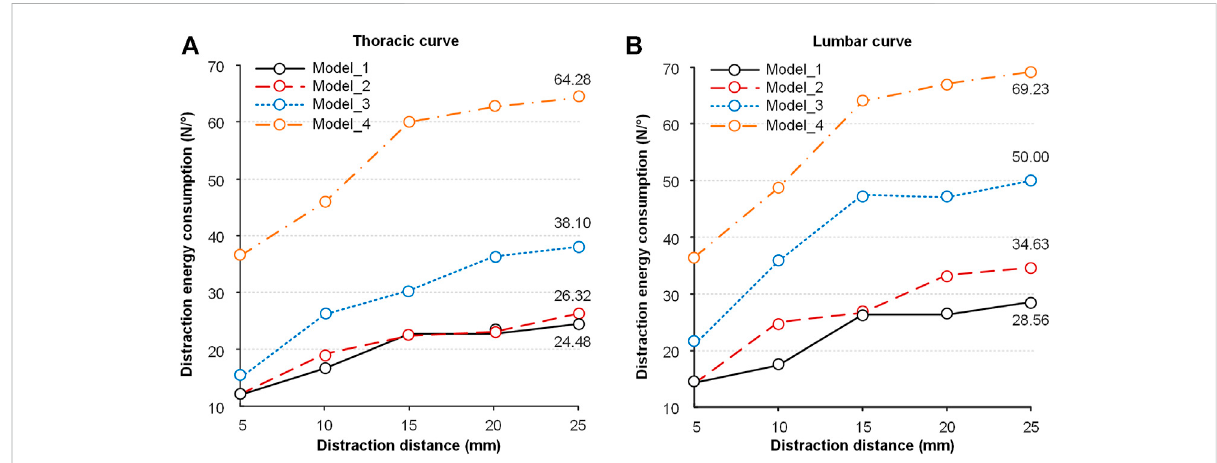
FIGURE 10 Distraction energy consumption of the four models in the process of distraction. (A) The distraction energy consumption in the thoracic curve. (B) The distraction energy consumption in the lumbar curve.